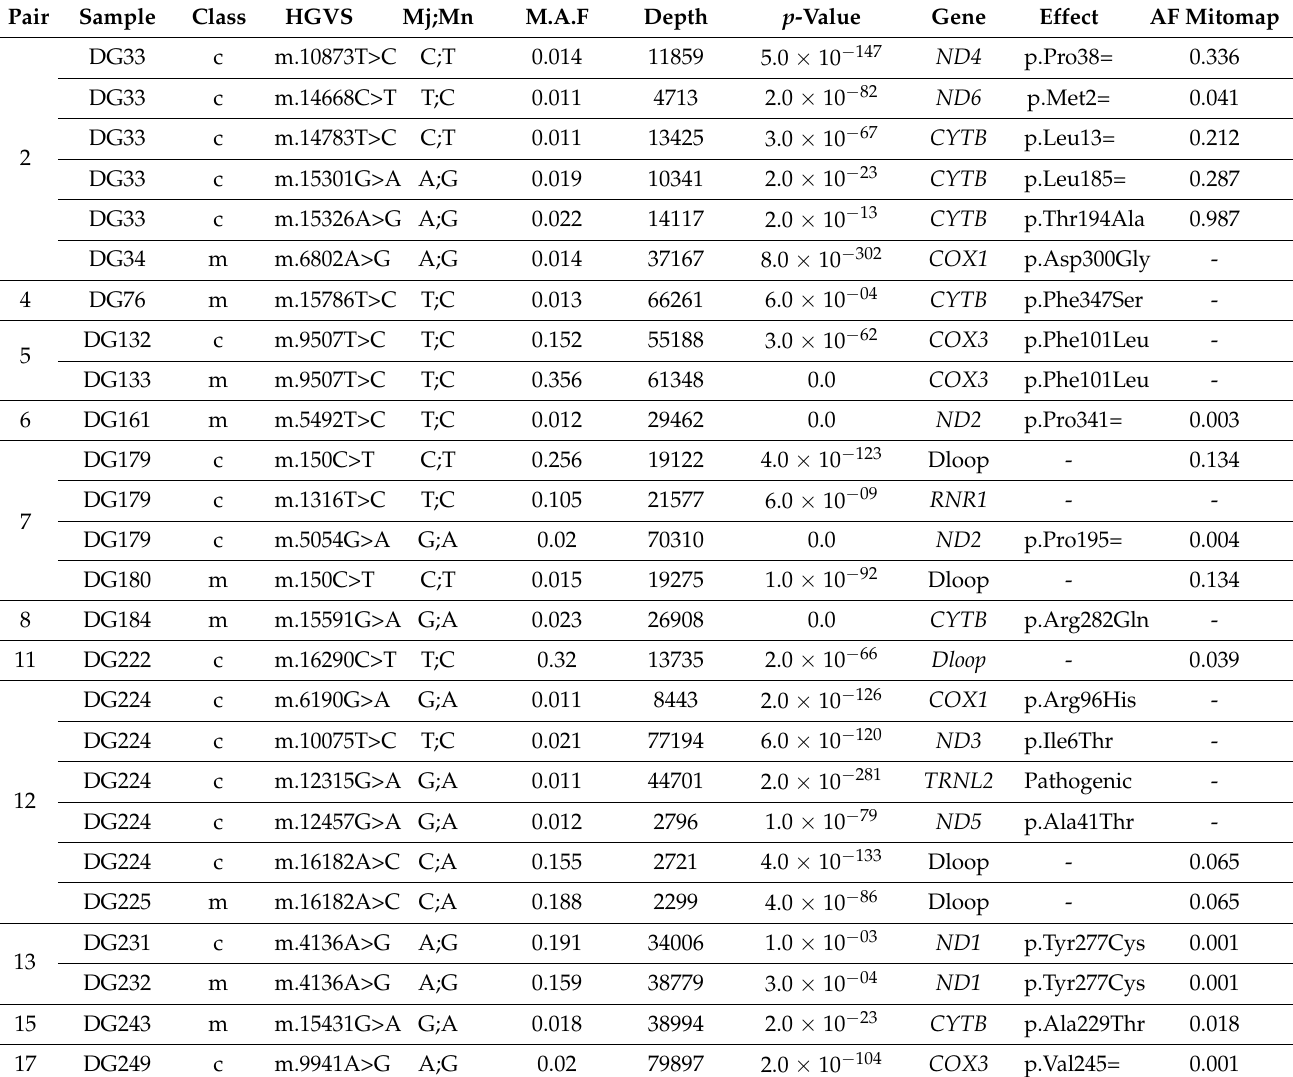
Table 2. High quality heteroplasmic